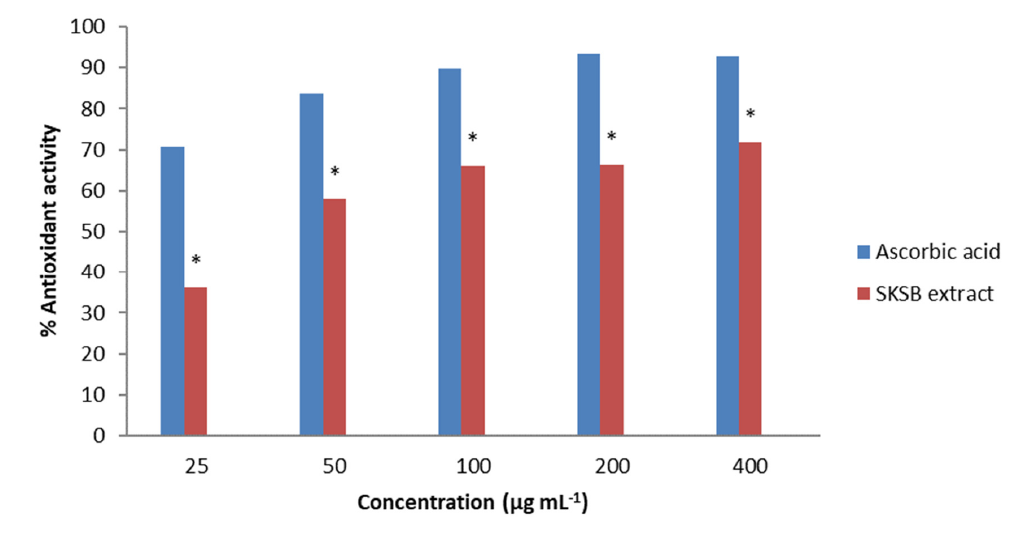
Figure 1. DPP assay of S. kunthianum stem bark extract *Significantly (P < 0.05) reduced compared to ascorbic acid